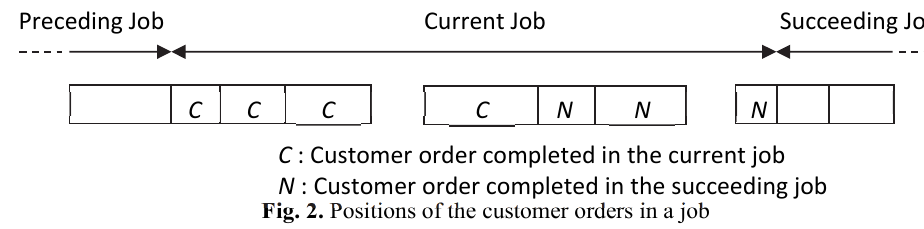
Fig. 2. Positions of the customer orders in a